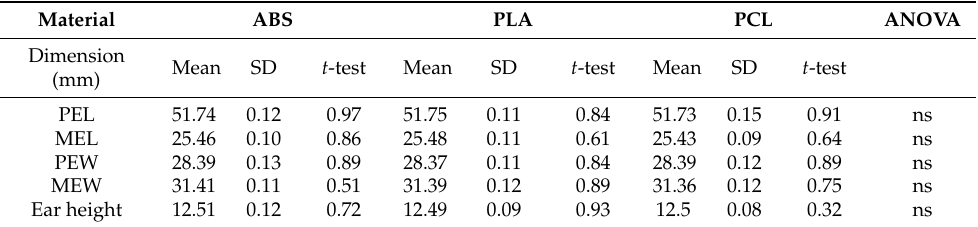
Table 3. Statistics for measurements for the dimensions of the porous auricular constructs in mm ( n = 5; the significance threshold was set as p < 0.05, p -value for all statistical test were ns = not